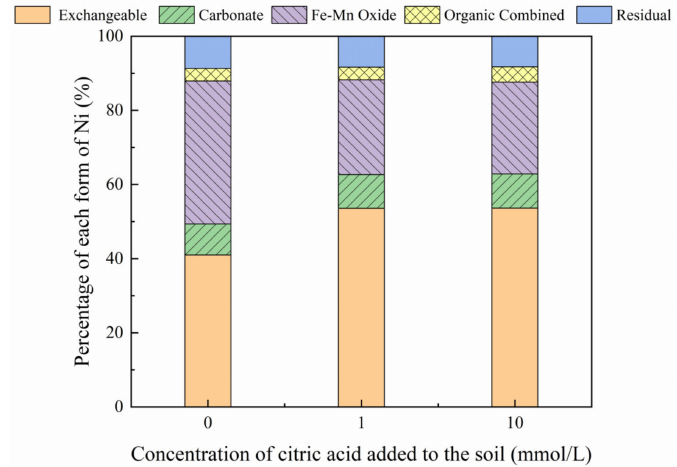
Figure 6. Distribution of different Ni forms in Ni-600 soil after the addition of citric acid (0, 1, 10 mmol/L).